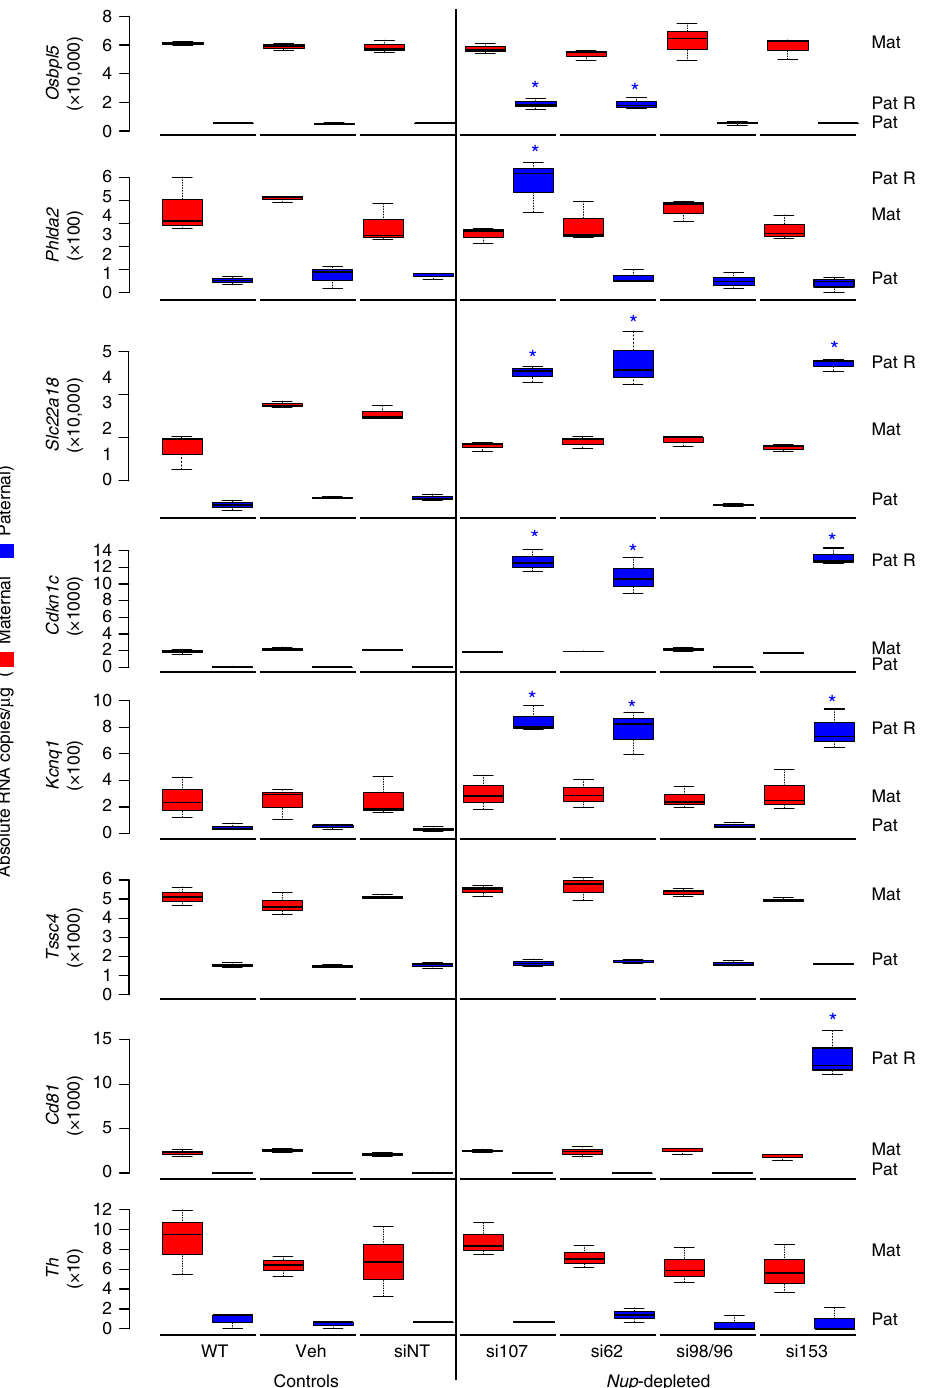
Fig. 4 Nup107, Nup62 , and Nup153 depletion reactivate a subset of paternal alleles at the Kcnq1ot1 domain. Absolute allelic transcript abundance of imprinted genes determined by droplet digital PCR in control and Nup -depleted XEN cells, as a measure of RNA copies µ g − 1 ( n = 3 biological samples). Center lines, medians; box limits, 25th and 75th percentiles as determined by R software; whiskers, 1.5 times the interquartile range from 25th and 75th percentiles; Mat, maternal; Pat, paternal; Pat R, reactivated paternally silent allele; *, signi fi cance p < 0.05 compared to the siNT control ( t test). Error bars,